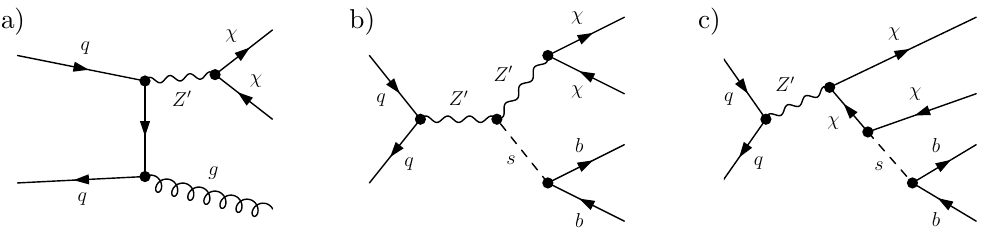
Figure 1 . Processes leading to missing transverse momentum signatures at the LHC. Left: a typical mono-jet process. Centre and right: processes leading to a mono-dark-Higgs